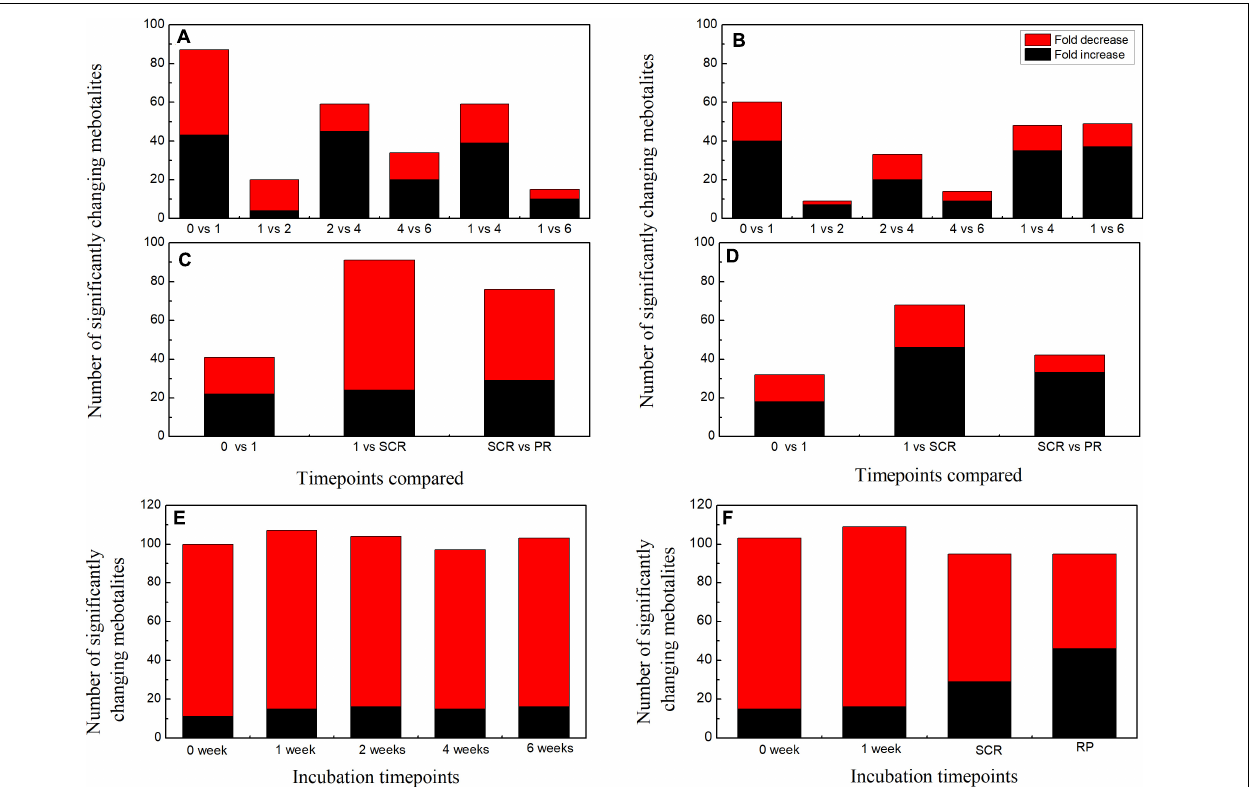
FIGURE 2 | Summary of the number of significant changes in metabolites with VIP value > 1 and P < 0.05 between different incubation time points for the embryos (A) and megagametophytes (B) of primary physiological dormant seeds (DS) and the embryos (C) and megagametophytes (D) of non-primary physiological dormant seeds (NDS). The numbers of significantly changing metabolites with VIP value > 1 and P < 0.05 between embryo and megagametophyte at each incubation time points for DS (E) and NDS (F) . VIP, variable importance in the